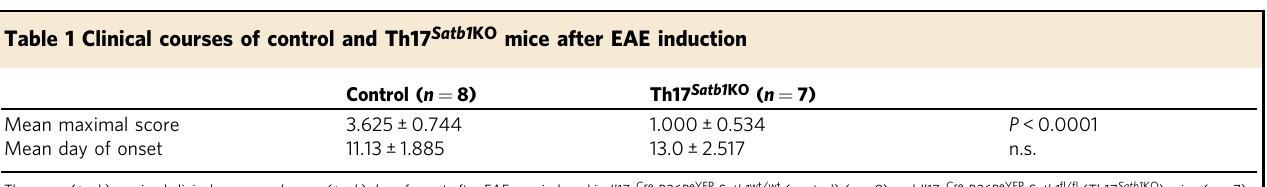
Table 1 Clinical courses of control and Th17 Satb1 KO mice after EAE induction